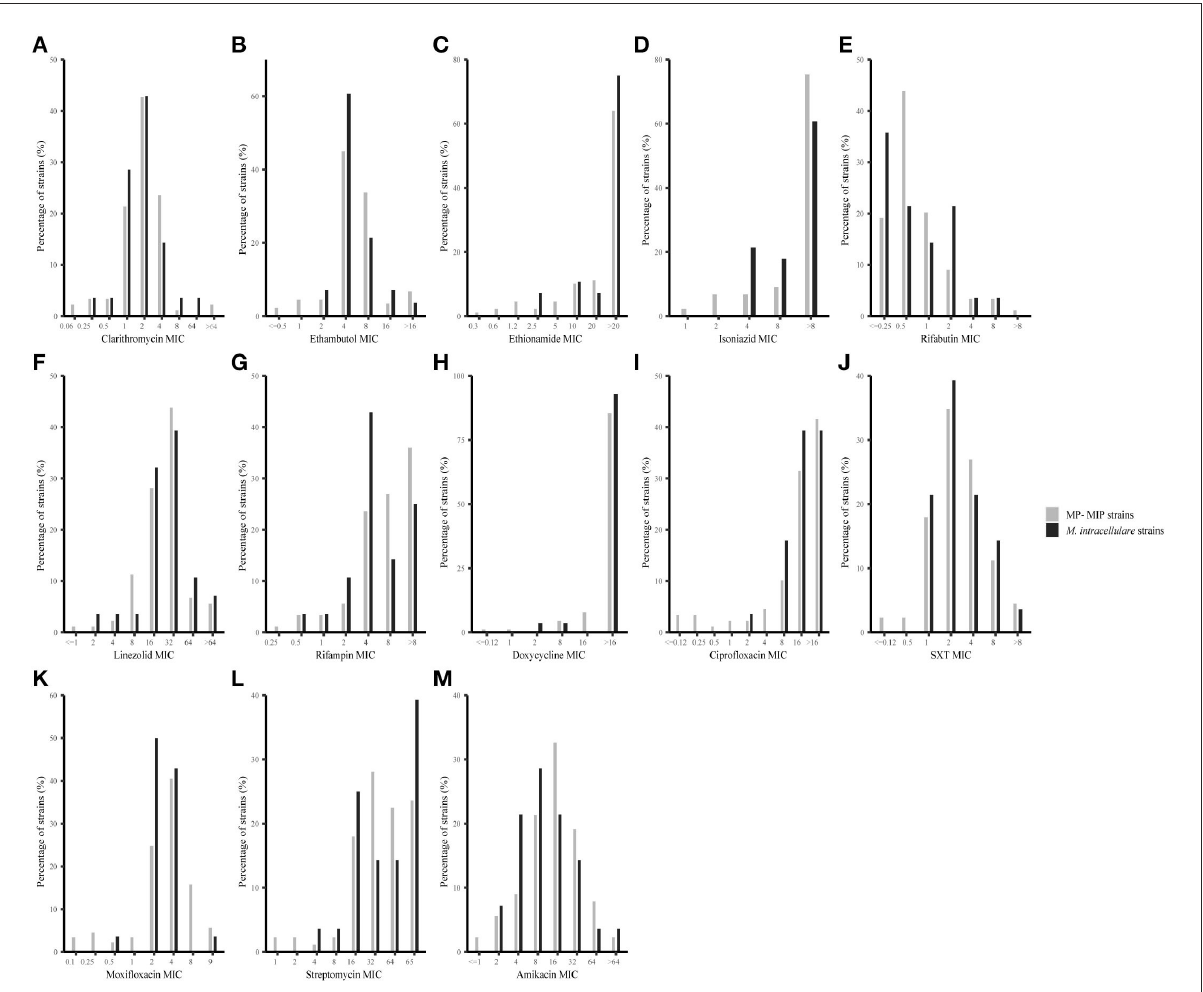
FIGURE2 MIC distributions for 28 M. intracellulare and 89 MP-MIP strains in this study. The vertical axis of each graph represents the number of strains corresponding to each horizontal coordinate as a percentage of the total number of strains. The black bar and gray bar represent M. intracellulare and MP-MIP strains, respectively. (A–M) Showed MIC distributions of clarithromycin, ethambutol, ethionamide, isoniazid, rifabutin, linezolid, rifampicin, doxycycline, ciprofloxacin, SXT, moxifloxacin, streptomycin, and amikacin,